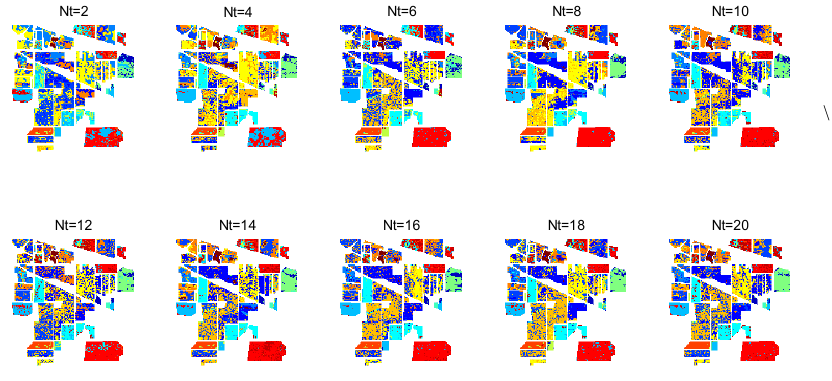
Figure 8. The obtained class maps with (cid:13)